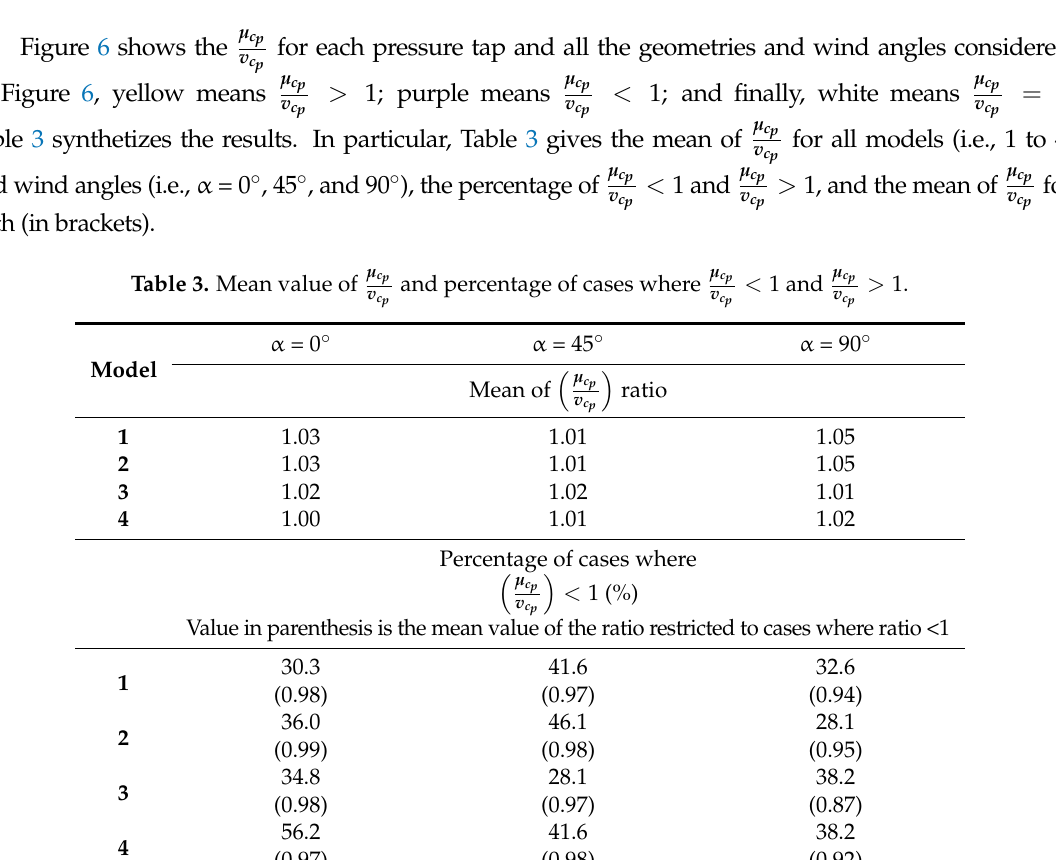
µ cp and percentage of cases where v cp